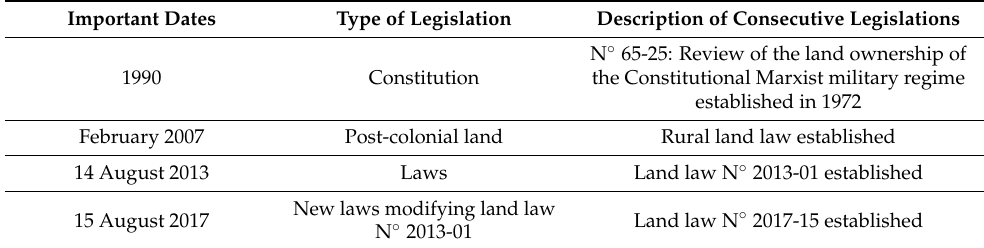
Table 1. Chronological evolution of land policies in Benin Republic after